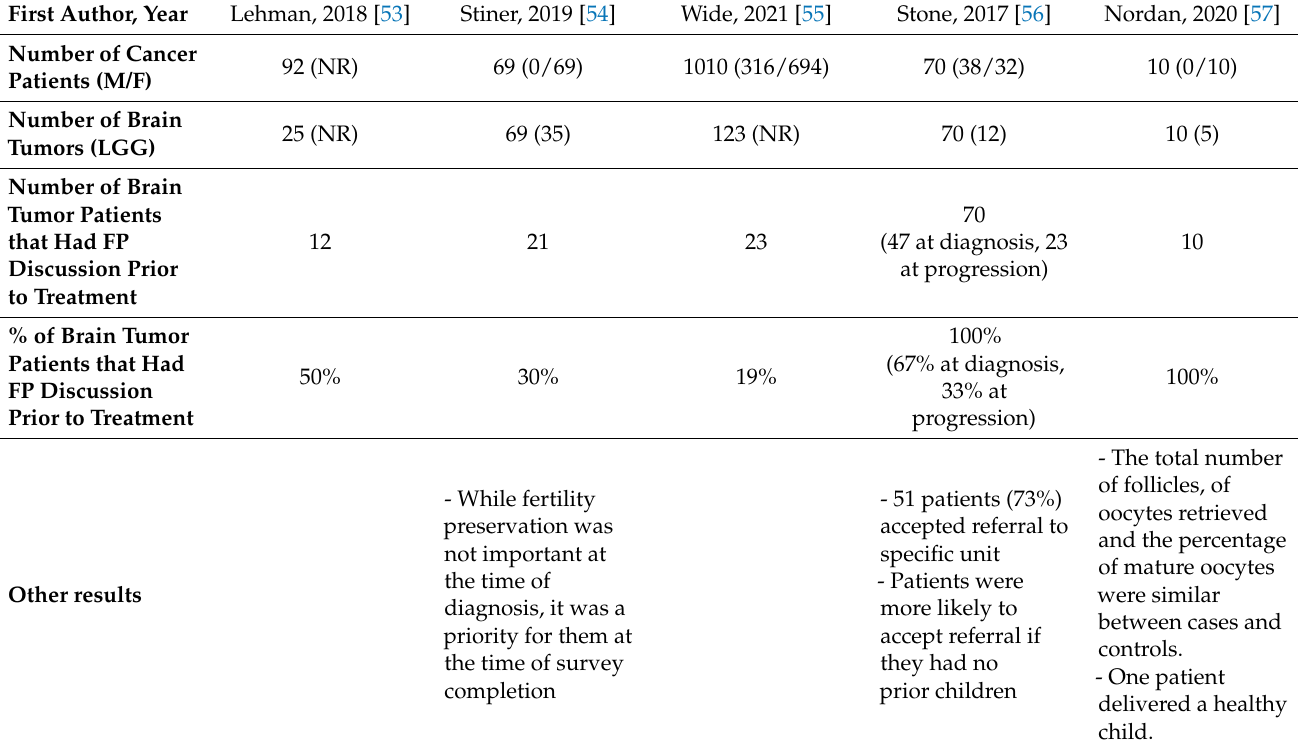
Table 2. Studies addressing FP discussion and results in LGG